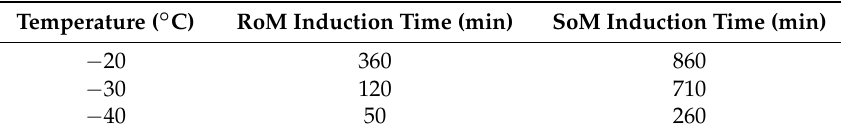
Table 6. Variation of crystallization kinetic parameters with temperature; Avrami exponent, n and crystallization rate constant, K c .